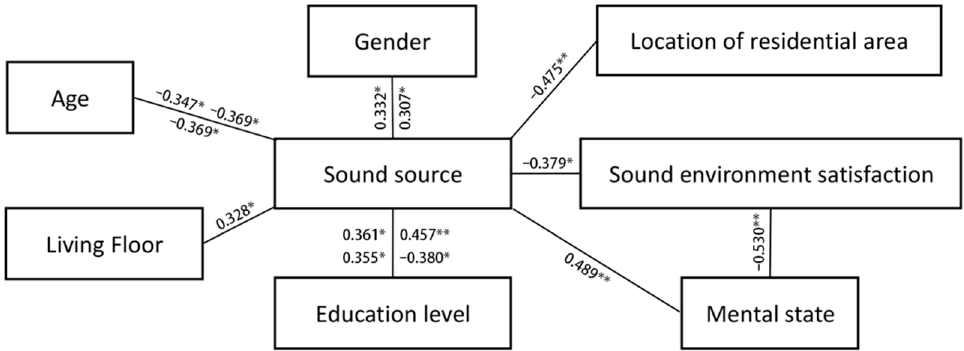
Figure 5. The relationship between different variables and the comfort evaluation of the acoustic environment (** indicates that the two-tailed test is significant at the 0.01 level, and * indicates that it is significant at the 0.05 level).